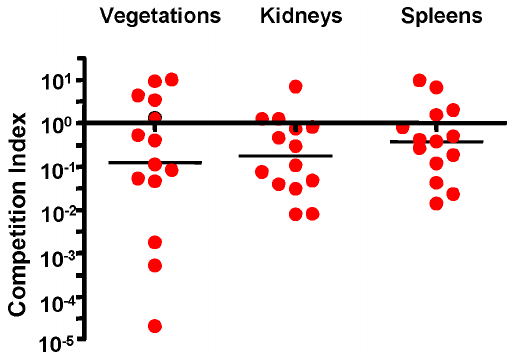
Figure 4. Competitive index (CI) analysis of WT and D srr1 mutant obtained in the rat model of endocarditis. Competition index (CI) was calculated as the ratio of the WT to the D srr1 mutant in each tissue, normalized for the ratio of strains within the inoculum. Circles represent data from individual animals. A CI above 10 0 (dashed line) indicates a competitive disadvantage of D srr1 compared with WT. Horizontal black bars indicates means of CIs.